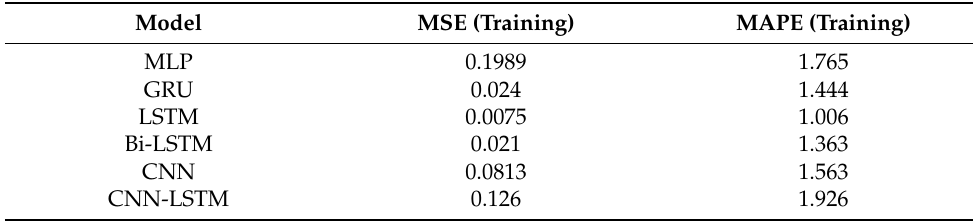
Table 7. The models’ training results using Snapchat data with six input features.